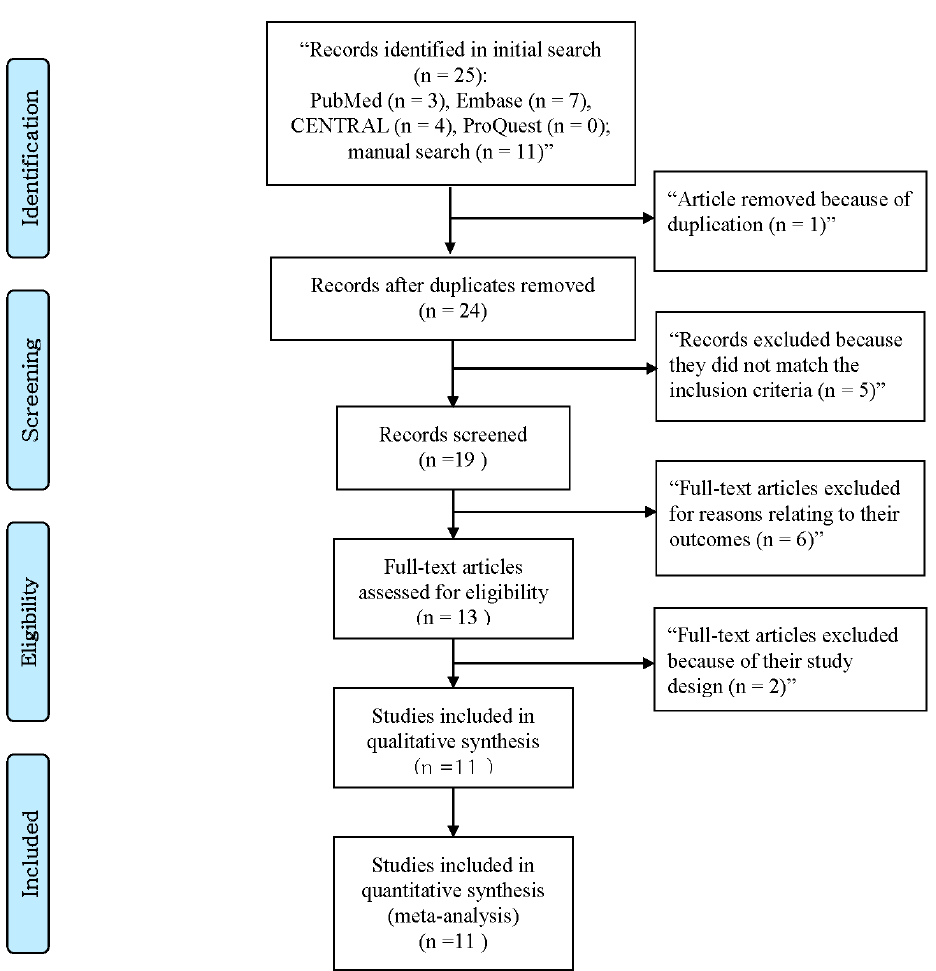
Figure 1. Study flow diagram.